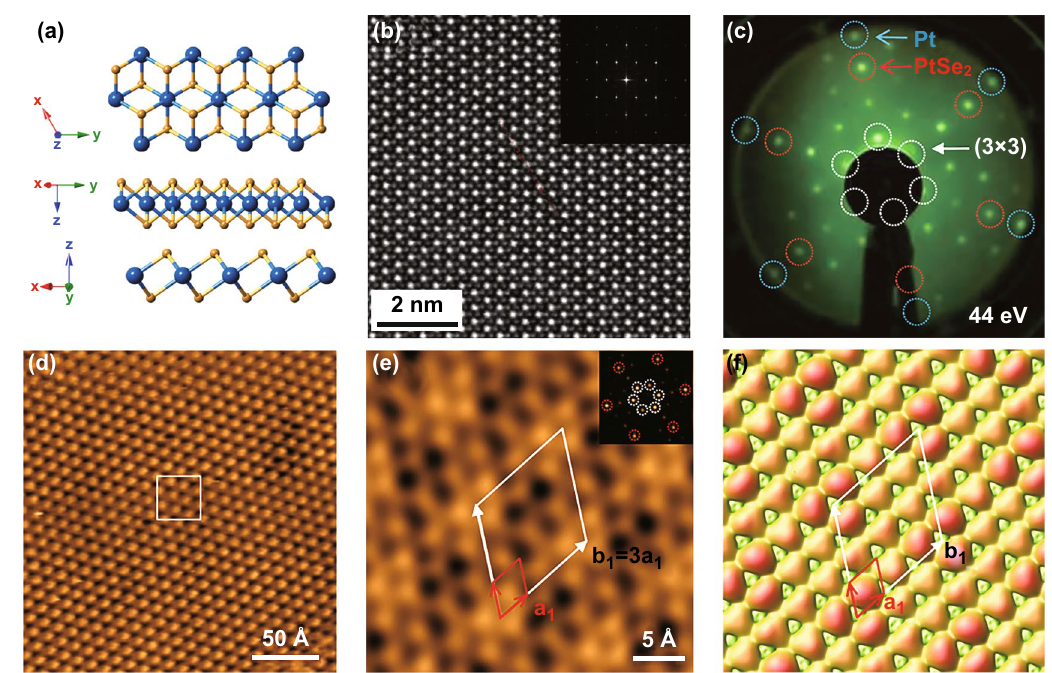
Fig. 1 Simulated and characterized crystal structure of PtSe 2 . a Crystal structure of PtSe 2 from different view. The gold balls represent Se atoms and blue balls represent Pt atoms. Reproduced with permission [33]. Copyright 2019, Springer Nature. b HR‑STEM image of a few‑layer PtSe 2 , inset: fast Fourier transform of the image. Reproduced with permission [28]. Copyright 2018, John Wiley and Sons. c LEED pattern of a mon‑ olayer PtSe 2 film on Pt substrate. d Large scale and e atomic resolution STM image of monolayer PtSe 2 film. f Simulated STM image of PtSe 2 by DFT calculation. Reproduced with permission [25]. Copyright 2015, American Chemical